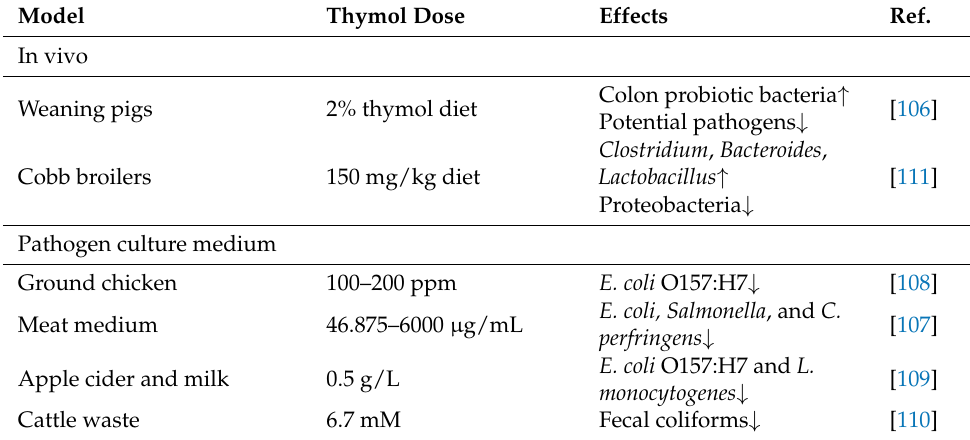
Table 4. Thymol prevents pathogen